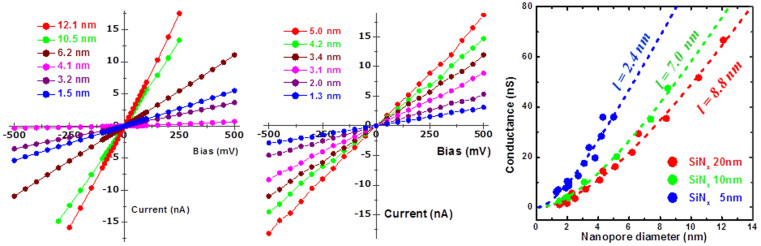
I-V characteristics of the quartz-substrate-based nanopore measured as a function of applied bias for various size pores in (a) 20-nm-thick and (b) 5-nm-thick SiNx membranes.(c) Ionic conductance versus nanopore diameter for various SiNx membrane thicknesses: 20 nm (red), 10 nm (green), and 5 nm (blue). Each dotted line and the effective thickness were achieved by fitting with Equation 1, as described in the text.